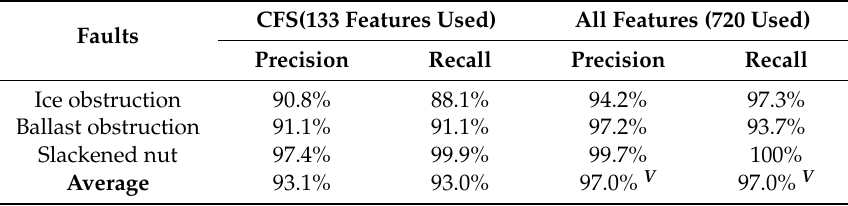
Table 2. Performance measurement for fault-sound